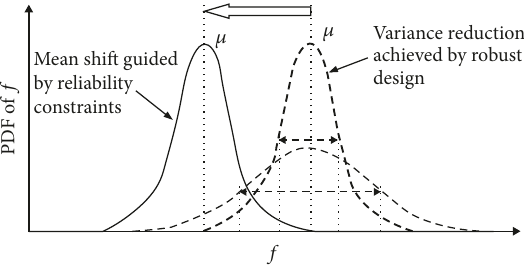
Figure 3: Typical RBRDO